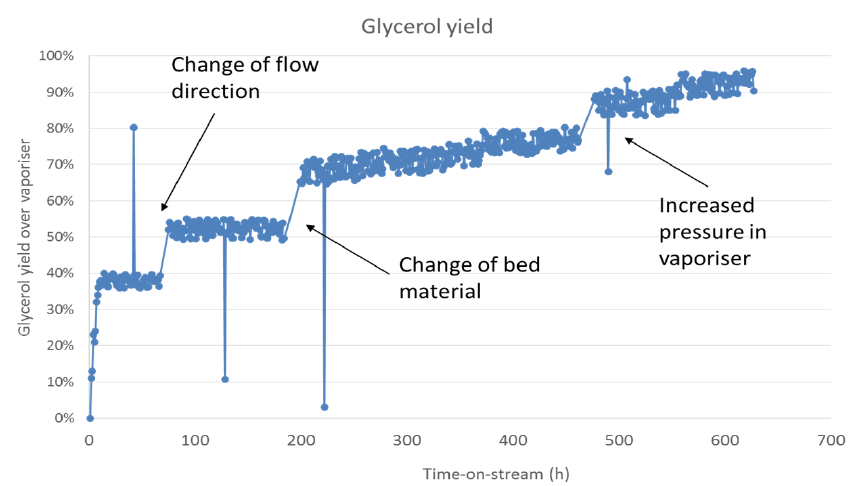
Figure 5. Results of the vaporization of glycerol over the second vaporizer configuration reproduced with permission [37].